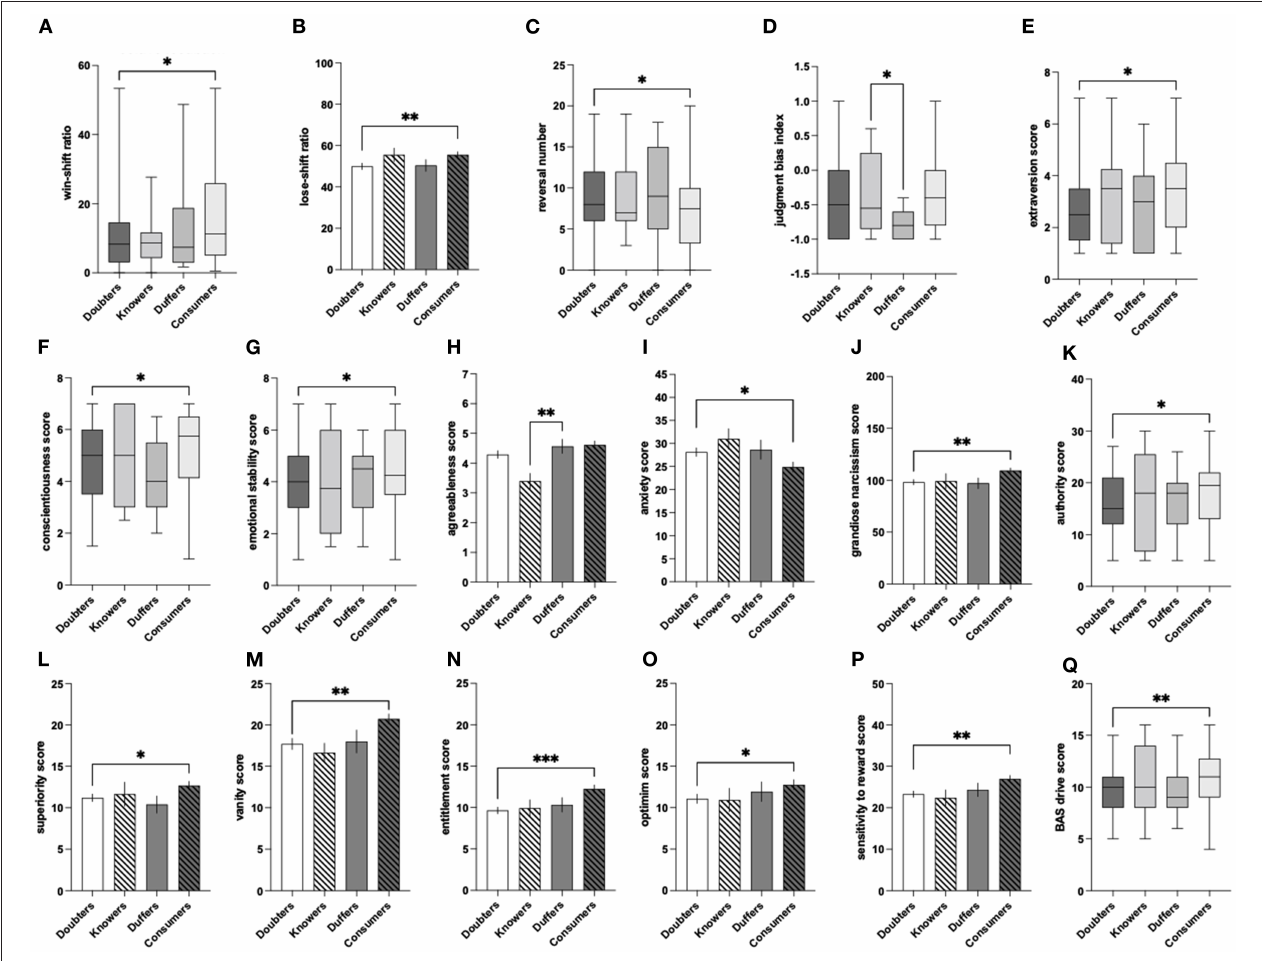
FIGURE 11 | Interphenotypic differences in the ratings of declared engagement for (A) win-shift %; (B) lose-shift %; (C) reversals; (D) cognitive judgment bias; (E) extraversion; (F) conscientiousness; (G) emotional stability; (H) agreeableness; (I) anxiety; (J) grandiose narcissism; (K) authority; (L) superiority; (M) vanity; (N) entitlement; (O) optimism; (P) sensitivity to reward; (Q) BAS drive for (A) conscientiousness; (B) anxiety; (C) grandiose narcissism; (D) authority; (E) superiority; (F) vanity; (G) entitlement; (H) BAS drive; and (I) BAS reward responsiveness. The data are presented as AVG ± SEM (the bar plots) or median with interquartile range (the box plots). * P ≤ 0.05 ** P ≤ 0.01 *** P ≤